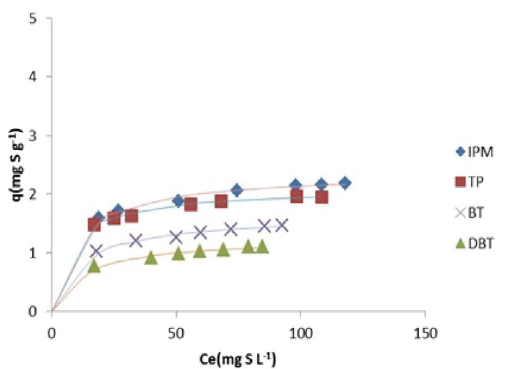
Fig. 8. The isotherms obtained at 20 °C for TP, BT, DBT and IPM sulfur containing molecules using the CLP-Ni sample. Dashed lines show the simulated curves based on the Langmuir-type correlation.